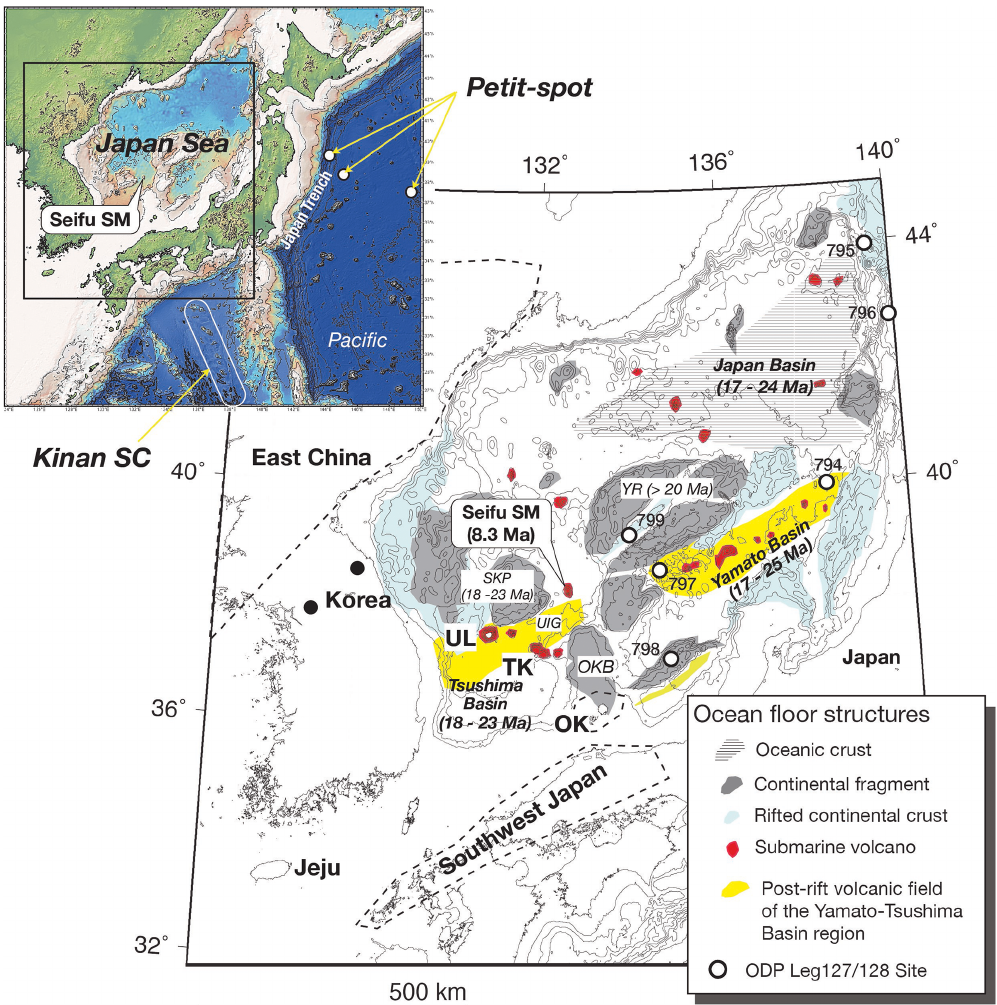
Figure 1. Location of the Seifu Seamount (SSM) and ocean floor structure (YR: Yamato Rise; OKB: Oki Bank; SKP: South Korea Plateau; UIG: Ulleung Interplain Gap) in the Sea of Japan (modified after Tamaki, 1988; Tamaki et al., 1992; Kim et al., 2011). Oceanic crust is only found in the Japan Basin. Note that the Seifu Seamount is on extended continental crust (white area) in the Japan Basin, located between the seamounts (submarine volcanoes) of the UIG and Yamato Basin (Kim et al., 2011). The ages of submarine volcanoes in this area are 17–10Ma. Ulleung Island (UL), Takeshima Island (TK), Oki Island (OK), and Jeju Island (CHJ) are mainly Quaternary volcanoes (<5Ma). Sites from ODP Legs 127 and 128 that recovered back-arc basin basaltic (BABB) rocks from Yamato Basin (Tamaki et al., 1992) and other locations of basalts in the circum-Sea of Japan area are shown (southwest Japan, including San-in and San-yo, northwest Kyushu, Korea, and east China). Petit-spot and the Kinan Seamount Chain are locations of alkali basalts on the Pacific and Philippine Sea plates, respectively (Hirano et al., 2006; Ishizuka et al., 2009). Age data are from Tamaki et al. (1992), Kaneoka et al. (1990, 1992), and Kim et al. (2011). The topographic and bathymetric maps were prepared using GeoMapApp (Ryan et al.,